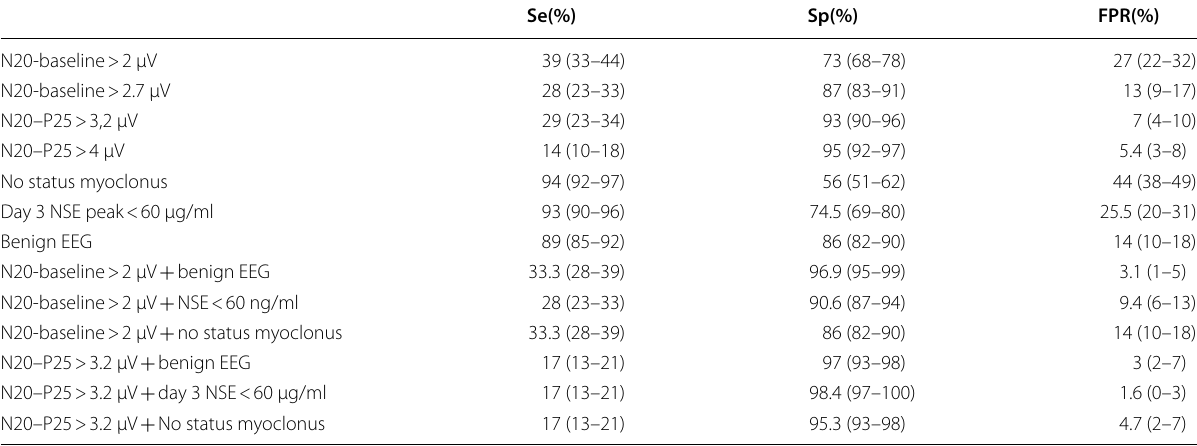
Table 3 Accuracy of the different thresholds SSEP, EEG benign patterns, no myoclonus, NSE peak at day 3 < 60 µg/ml, and combinations for prediction of good outcome